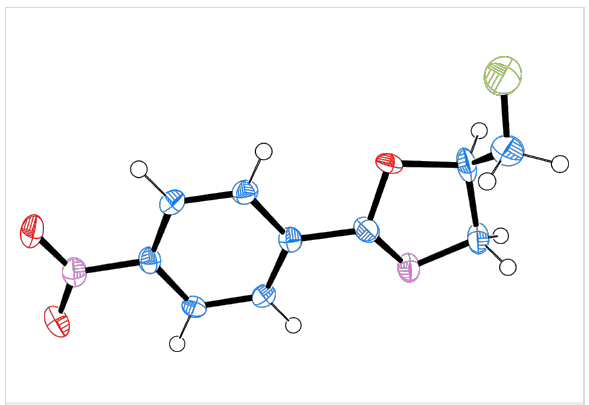
Figure 4: X-ray molecular structure of compound 2c . Thermal ellip- soids shown at the 50% propability level. Torsion angle ( F1–C10–C9–O1 − 73.4°) consistent with the fluorine gauche effect. CCDC number 1815371.